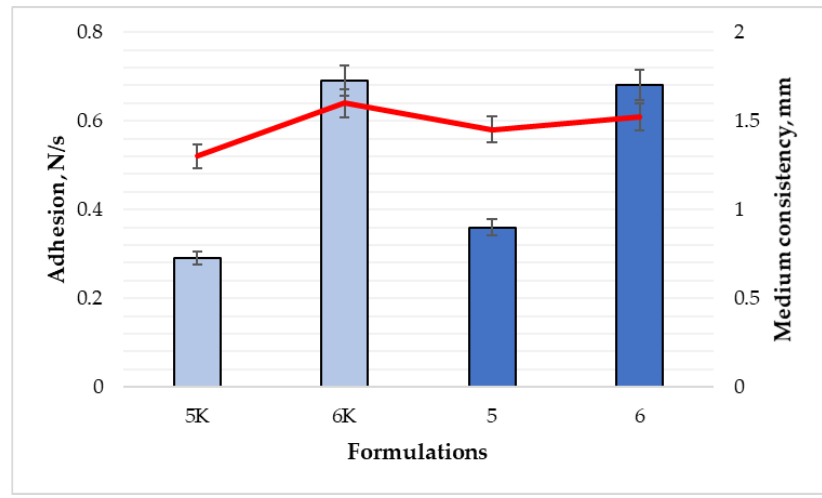
Figure 8. Comparison of adhesion and cohesiveness between formulations (n = 8). The composition values are given in Table 1. p < 0.05 between 5 and 5K compositions; p > 0.05 between 6 and 6K; 5 and 6 compositions.